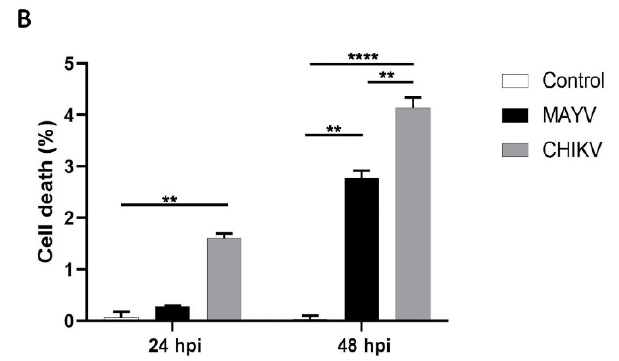
Figure 5. Cell death in primary human astrocytes following MAYV and CHIKV infection. ( A ) Live and dead cells were stained with NucBlue ® Live reagent (blue) and NucGreen ® Dead reagent (green) after infection with MAYV or CHIKV at MOI 5 at 24 and 48 hpi. Mock-infected cells were used as control. ( B ) Percentage of cell death. Mean values are represented. One-way ANOVA with Bonferroni’s post hoc test was performed. ** represents p < 0.005, **** represents p < 0.0001. The error bars represent the difference in the numbers of apoptotic cells counted in three fields. An average number of three fields were counted in the experiment ( n = 2).